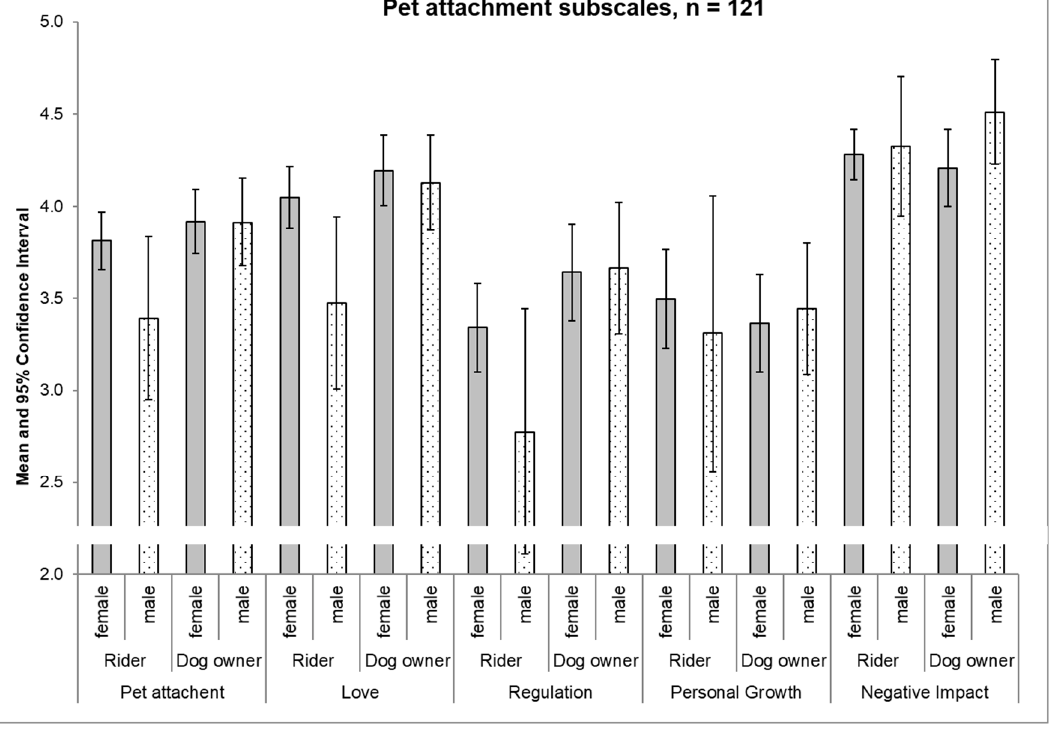
Figure 2. Pet attachment and subscales scores of riders and dog owners (mean and 95% confidence intervals) by sex.